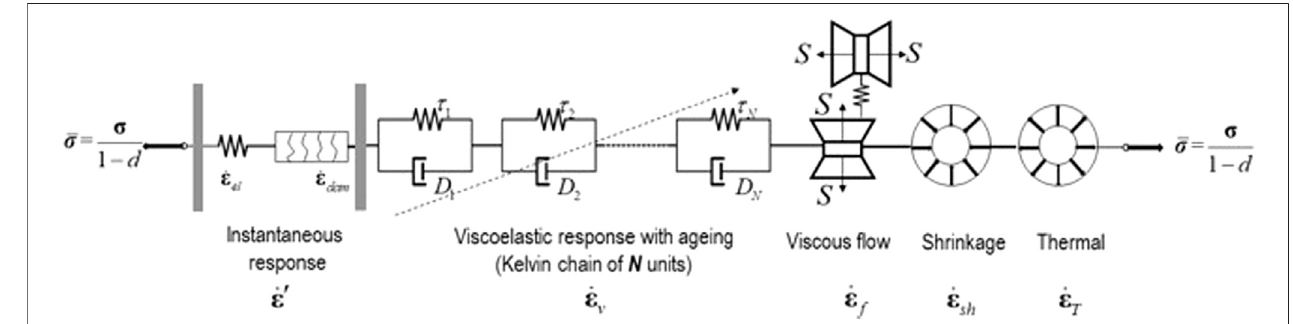
FIGURE 1 | Rheological model for coupling in the GED-MPS